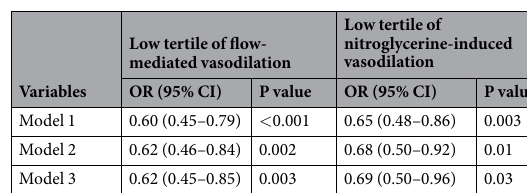
Table 2. Multivariate Analysis of the Relations between Vascular Dysfunction and Mild Target Level of Low- Density Lipoprotein Cholesterol ( ≤ 100). Low tertile of flow-mediated vasodilation indicates less than 2.7%. Low tertile of nitroglycerine-induced vasodilation indicates less than 10.6%. Model 1: unadjusted model. Model 2: adjusted for age, gender. Model 3: adjusted for age, gender, body mass index, current smoking, presence of hypertension and diabetes